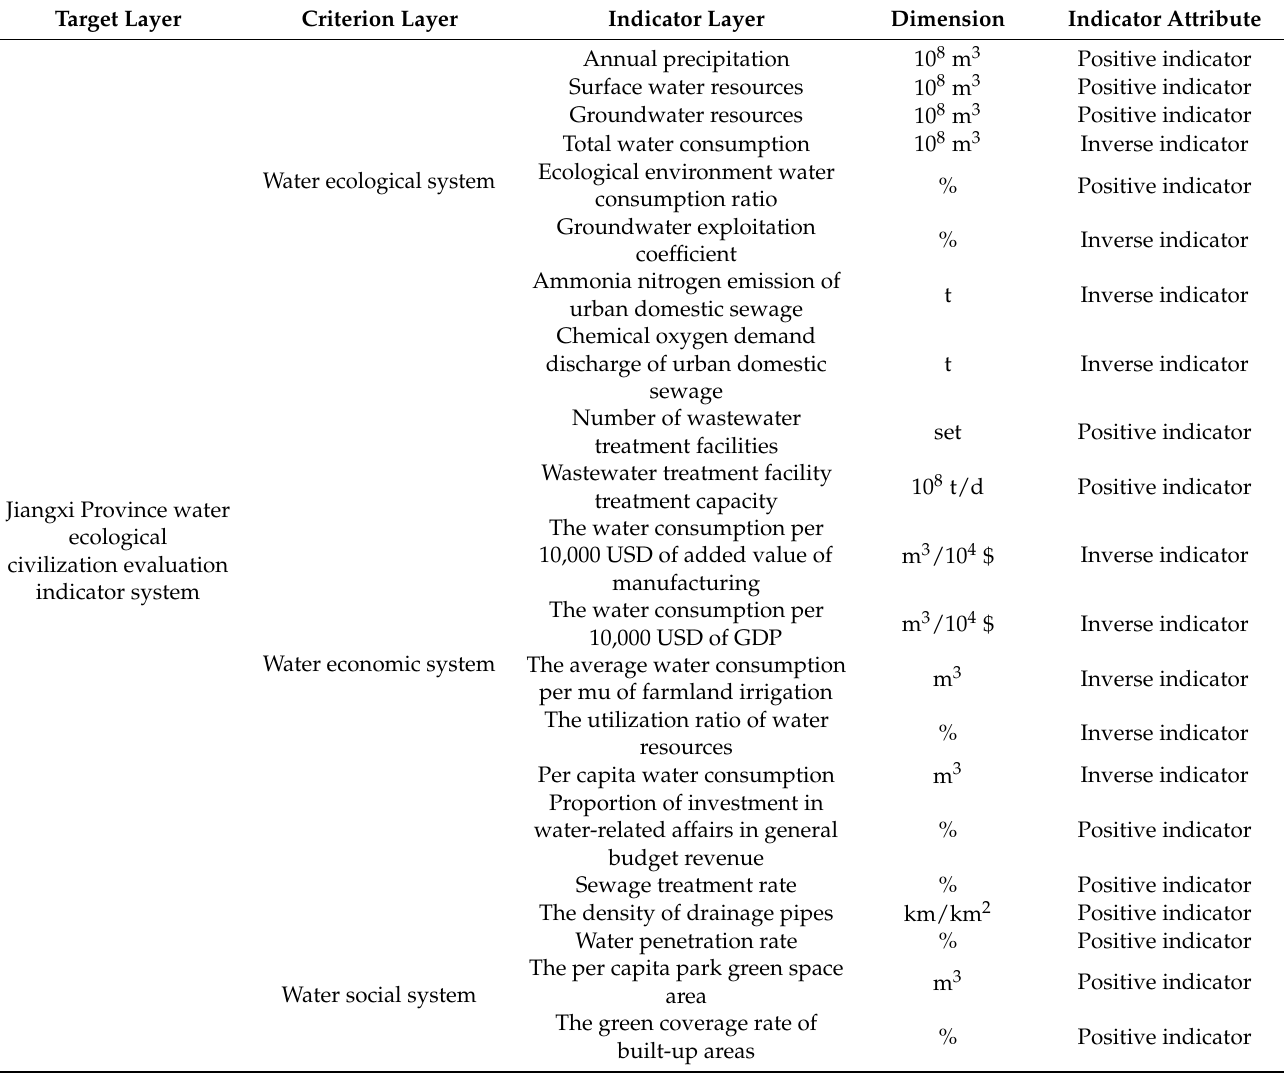
Table 2. Indicator